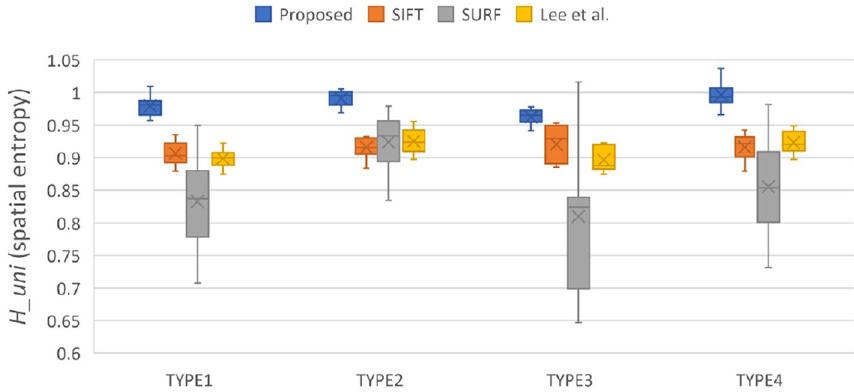
Figure 3. Compare the feature point distribution uniformity calculated by four methods in each type.